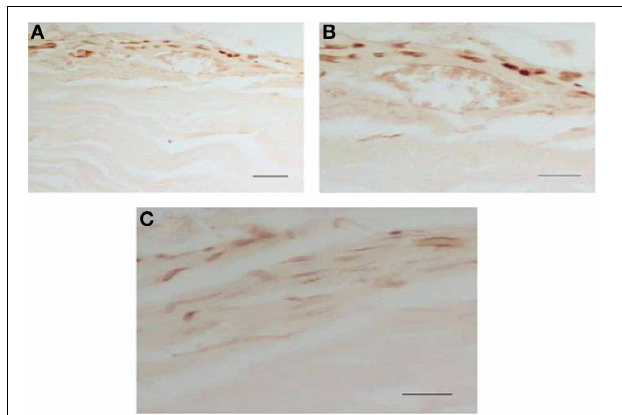
FIGURE 11 | Morphine withdrawal activates ERK1/2 in the right and left ventricle. Rats were rendered dependent on morphine during 7 days and, on day 8, were injected with saline or naloxone (subcutaneously). Controls groups received placebo pellets at the same time schedule and on day 8 were given with saline or naloxone. 90min after injections, rats were perfused and the right and left ventricle were processed for phospho (p)ERK1/2 immunohistochemistry. Photographs show the immunohistochemical detection of pERK1/2 in the left ventricular wall (A–C) . These results are representative of four independent experiments. Normaski interference optics. Scale bar 30mm (A) , 20mm (B,C) . ERK, extracellular signal regulated